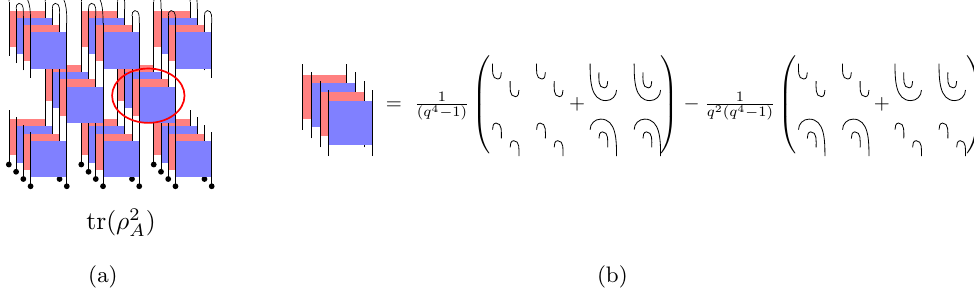
Figure 10 . Permutations in the circuit average. The blue and red blocks represents the independent Haar random matrices and their complex conjugate. (a) The circuit structure for n = 2. Red circle encloses 2 n = 4 layers of unitaries, which can be regarded as an 8 n -leg tensor that has 4 n legs at the bottom as input and 4 n legs on the top as output. (b) Random average over the 2 n layers in each block generates a sum over permutation elements with weights.